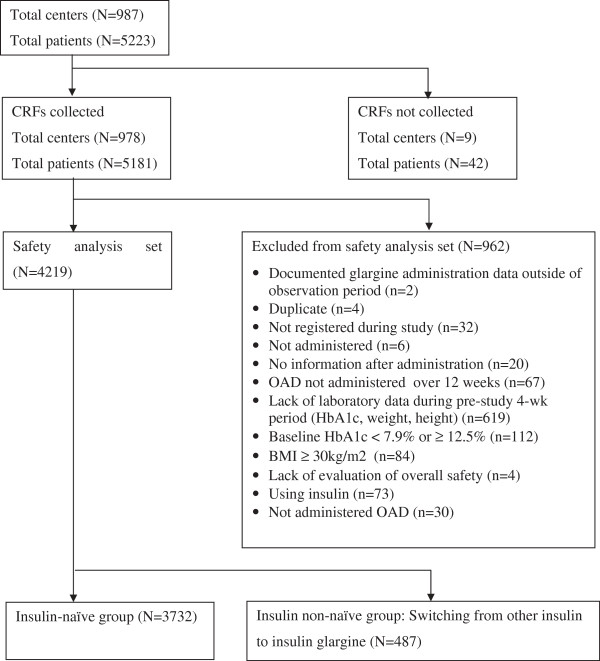
Patient disposition.